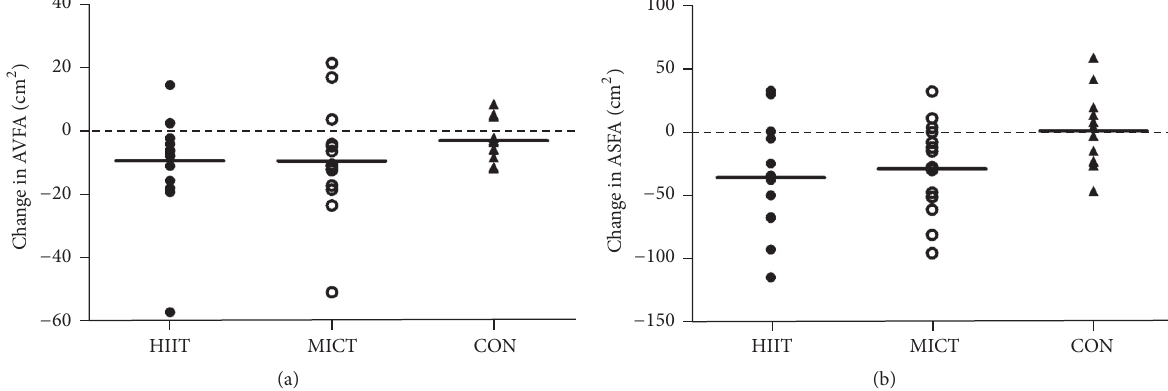
Figure2:Changesin(a)abdominalvisceralfatarea(AVFA)and(b)abdominalsubcutaneousfatarea(ASFA)ofparticipantspostintervention in HIIT, MICT, and CON